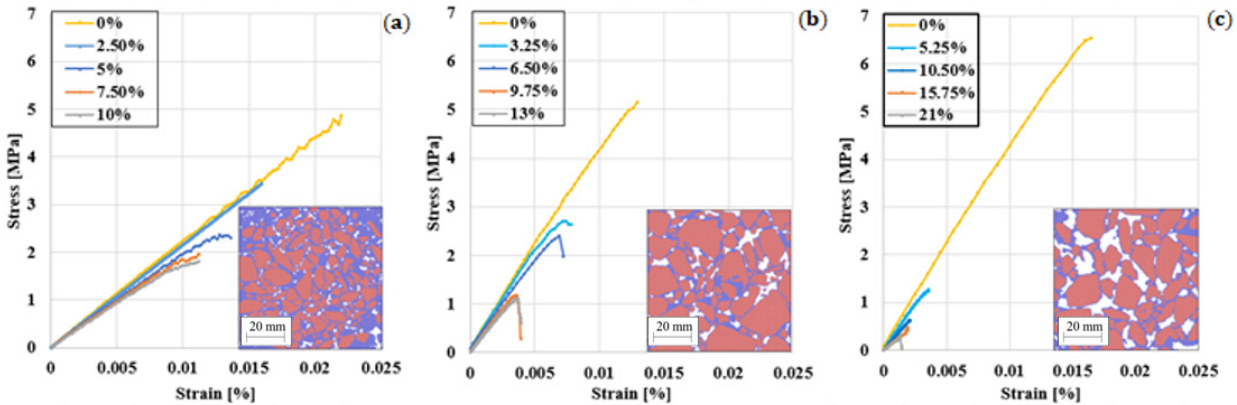
Figure 11. Stress/strain curves for PA #1 ( a ), PA #2 ( b ) and PA #3 ( c ) samples.